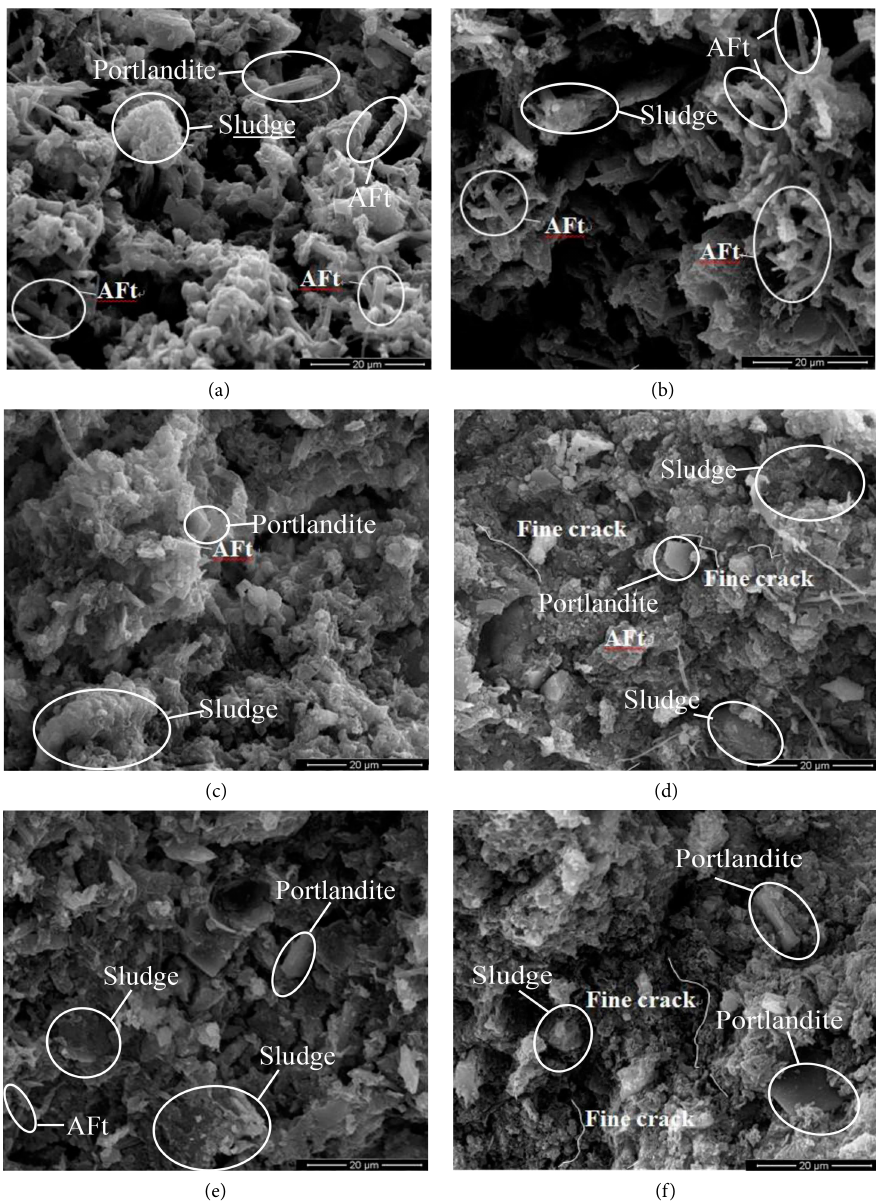
Figure 10: SEM images of solidified sludge bodies under different conditions. (a) Solidified Sample 1. (b) Drying saturated Sample 1. (c) Solidified Sample 4. (d) Drying saturated Sample 4. (e) Solidified Sample 7. (f) Drying saturated Sample